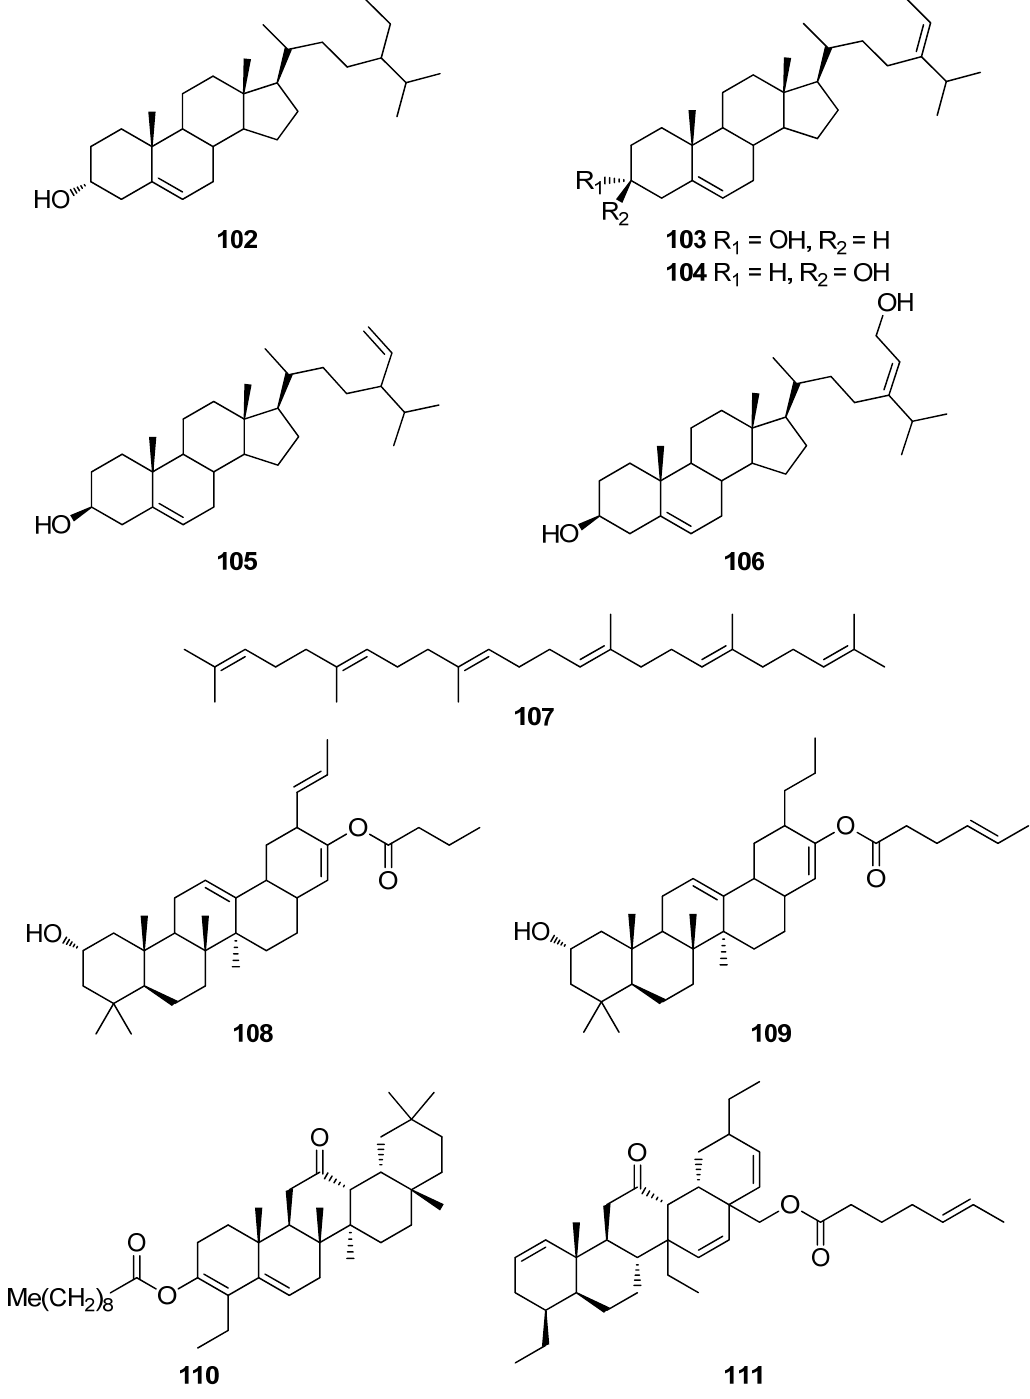
Figure 10. Chemical structures of compounds 102 – 111 .